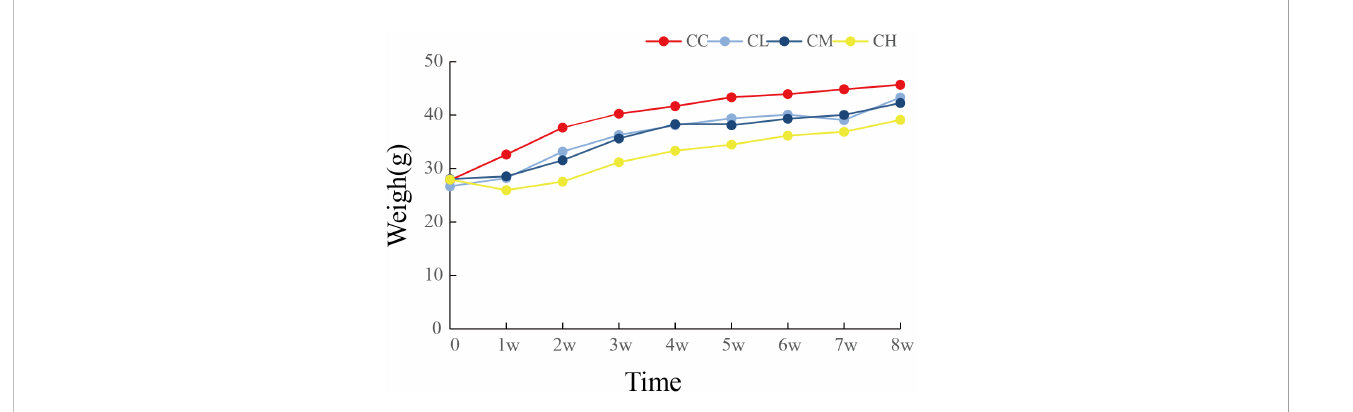
FIGURE 2 Weight changes of mice. CC: control group, CL: low-dose GFPS group, CM: medium-dose GFPS group, CH: high-dose GFPS